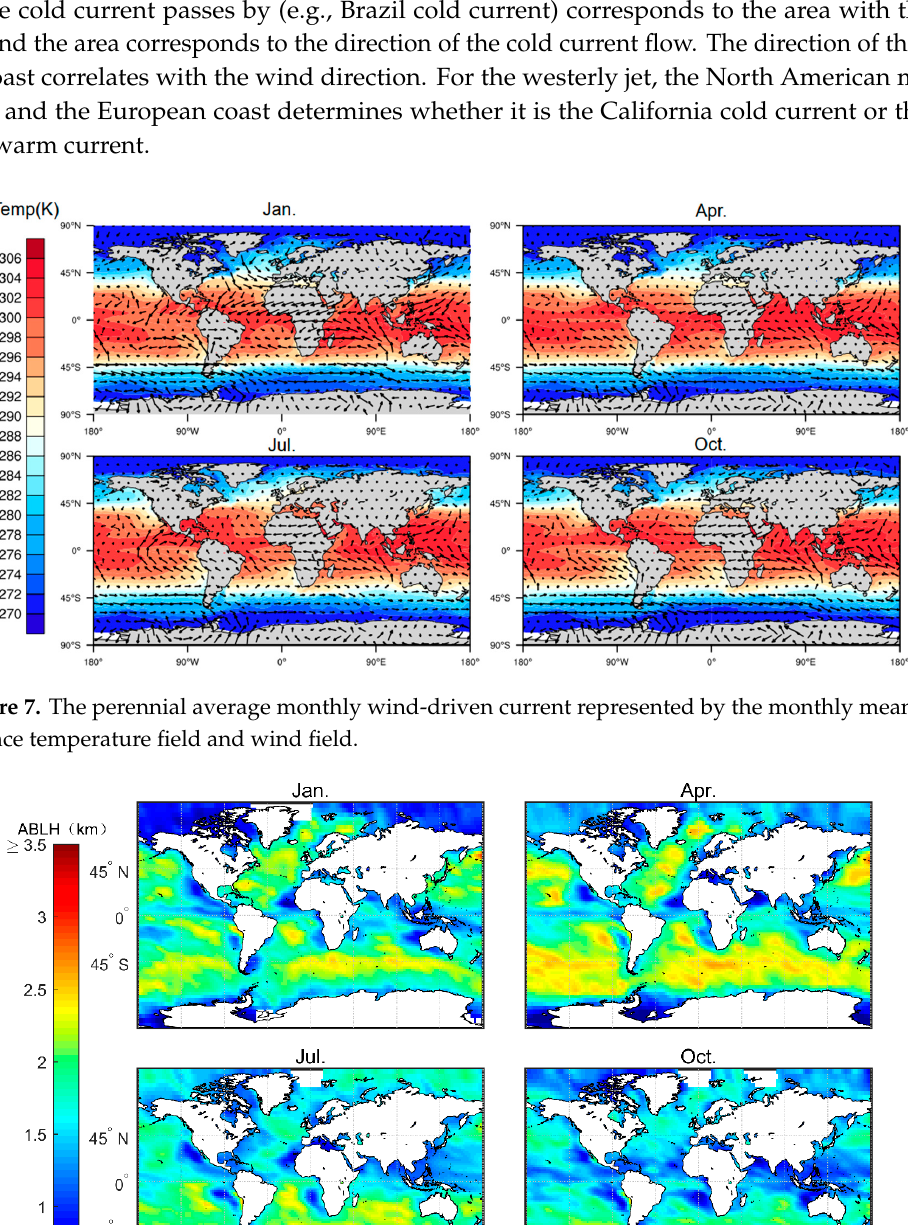
Figure 8. Average MBLH over four months based on the 2007–2011 CDAAC “echprf” bending angle products.